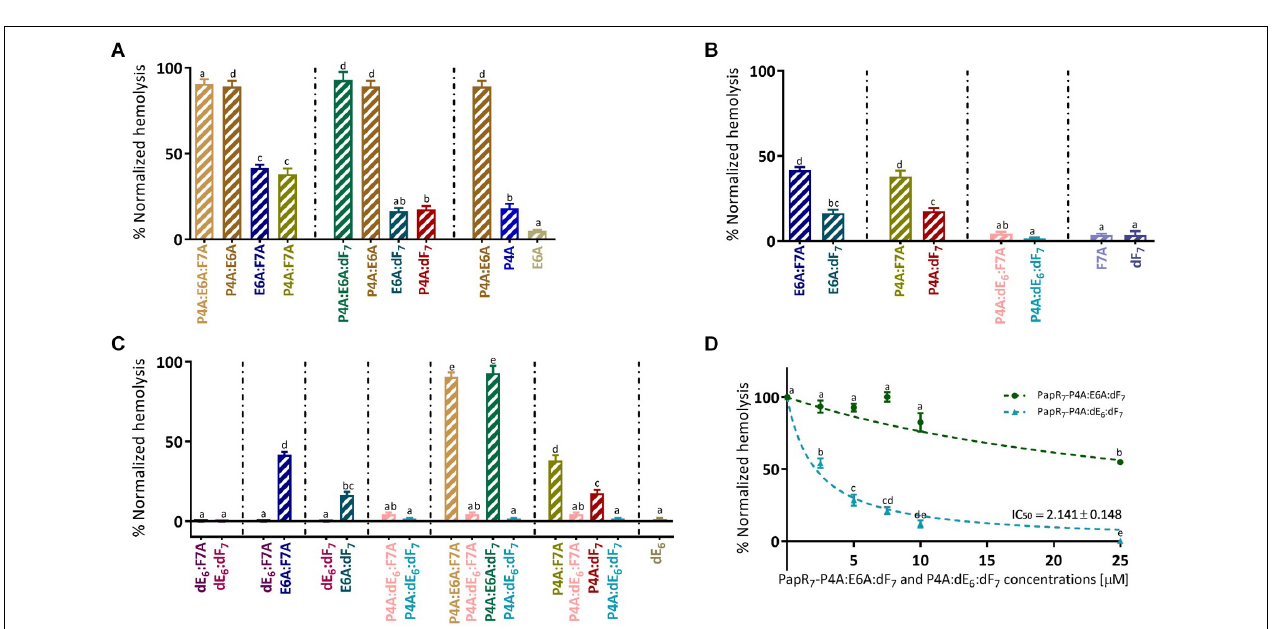
FIGURE 6 | Exploring specific combination replacements effect on Bc virulence inhibition . Hemolytic activity of supernatant B. cereus ATCC 14579 treated cultures in 10 µ M of PapR 7 -derived peptides normalized to untreated supernatants of bacterial cells at end lag phase of bacterial growth (OD 600 of 0.1 ± 0.03; mean ± SEM, n = 9). Hemolytic activities on human red blood cells were classified by exploring the role of three PapR 7 crucial positions in PlcR activity; (A) Role of individual and combined Pro4 or Glu6 residue replacements. (B) Effect of Phe7 replacement. (C) Importance of Glu6 and its stereoisomer substitution. Hemolysis inhibition dose response curves of B. cereus ATCC 14579 treated supernatant cultures in different concentrations of (D) PapR 7 – P4A:E6A:dF 7 and P4A:dE 6 :dF 7 normalized to untreated bacterial culture (mean ± SEM, n = 9). Different letters indicate statistically significant differences between PapR 7 -derived peptide treatments ( p <